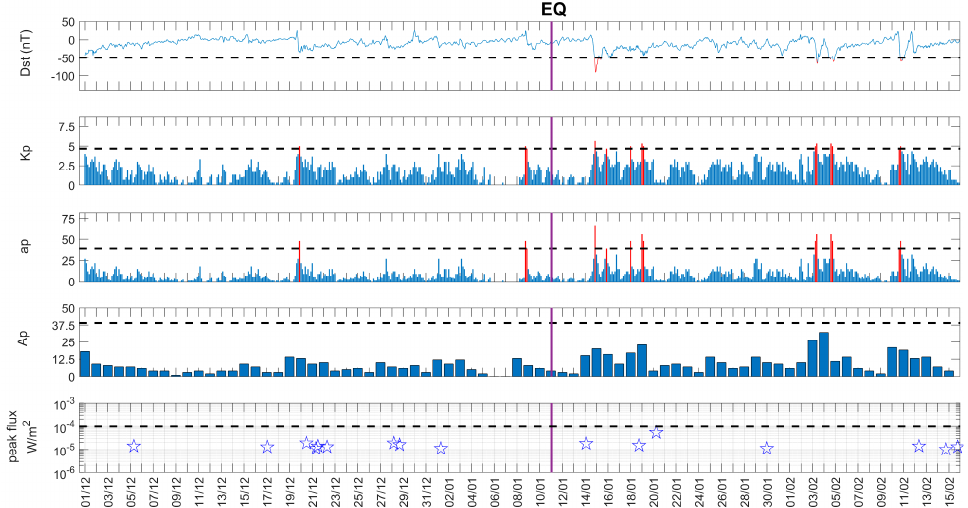
Figure 3. Geomagnetic indices Dst, Kp, ap, and Ap, as well as solar flares during the time period 1 December 2021 − 15 February 2022, which are indicated as pentagrams. Red-colored parts indicate values exceeding the thresholds marked by the horizontal black dashed lines. In the case of the bo tt om panel, the threshold separates M class from X class solar fl ares.